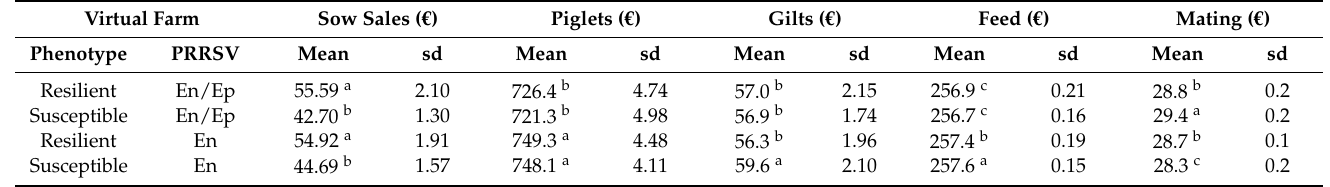
Table 9. Main economic parameters by sow and year for each virtual farm by taking into account the phenotype of the sow (Resilient or Susceptible) and the PRRSV epidemiological scenario (Endemic versus Endemic and Epidemic). The epidemic phase corresponds to one PRRSV outbreak of 24 weeks in duration every three years.